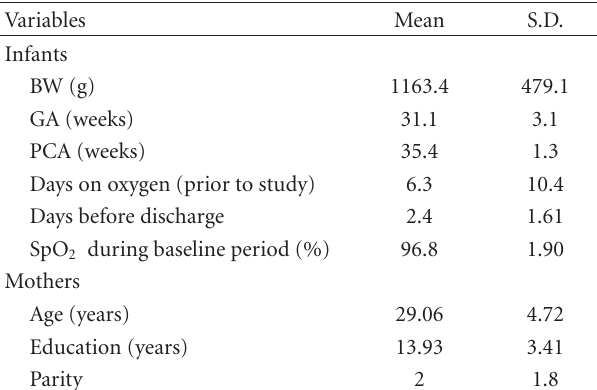
Table 1: Characteristics of the sample ( N = 34): 14 males, 20